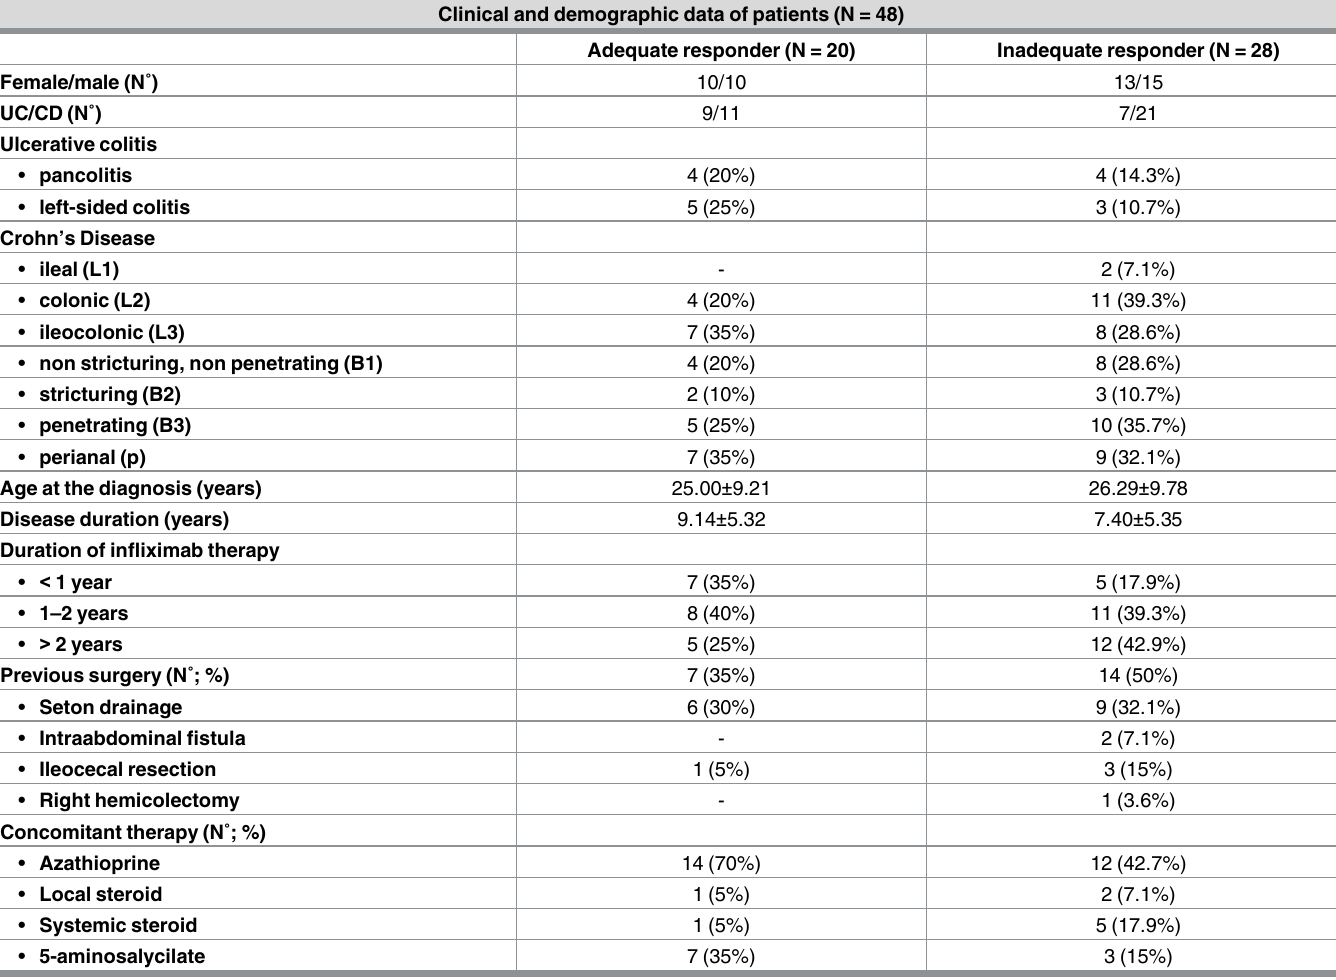
Table 1. Clinical and demographic data of 48 enrolled inflammatory bowel disease